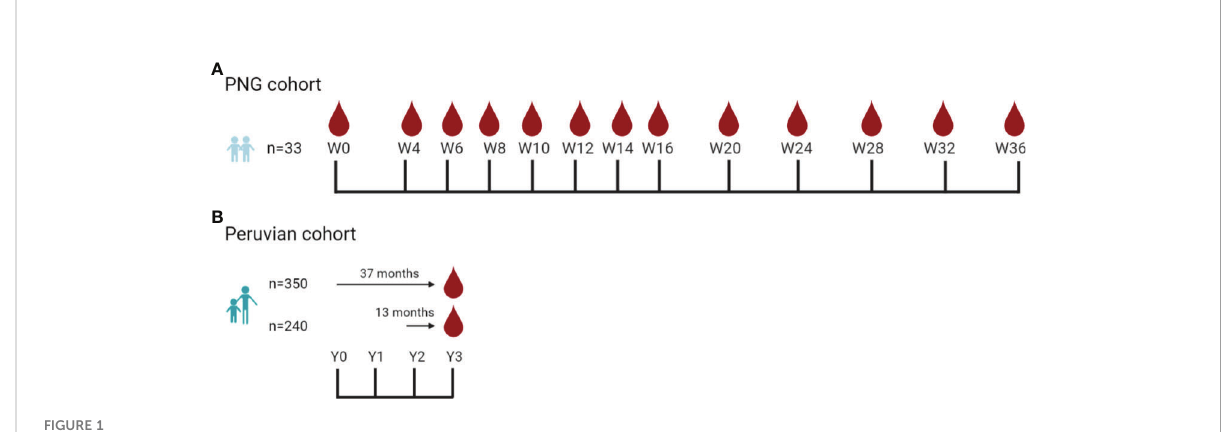
FIGURE 1 Sample collection timepoints used in the antibody kinetics study and the classi fi cation assessment study. (A) Asymptomatic children aged 5 – 10 years ( n = 31) were enrolled in the Papua New Guinea (PNG) cohort study (Albinama), conducted in Maprik District, PNG, from August 2009 to May 2010 (Robinson et al., 2015). There were no reinfections during follow-up. Samples were collected at 13 timepoints for 36 weeks. (B) The Peruvian cohort study was conducted in Cahuide and San Jose ́ de Lupuna, Loreto, Peru, from December 2012 to December 2015 (Rosas- Aguirre et al., 2017). Serum collected at the end of the study in the Peruvian cohort (Rosas-Aguirre et al., 2017) was used to assess the performance of IgG3 and total IgG antibody levels as markers for classifying recent P. vivax infection in the prior 9 months. In total, there were 590 individuals aged 3 – 85 years: 350 samples from individuals that were followed up for 37 months and 240 samples from individuals that were followed up for 13 months and qPCR data available in the last 13 months. Created in